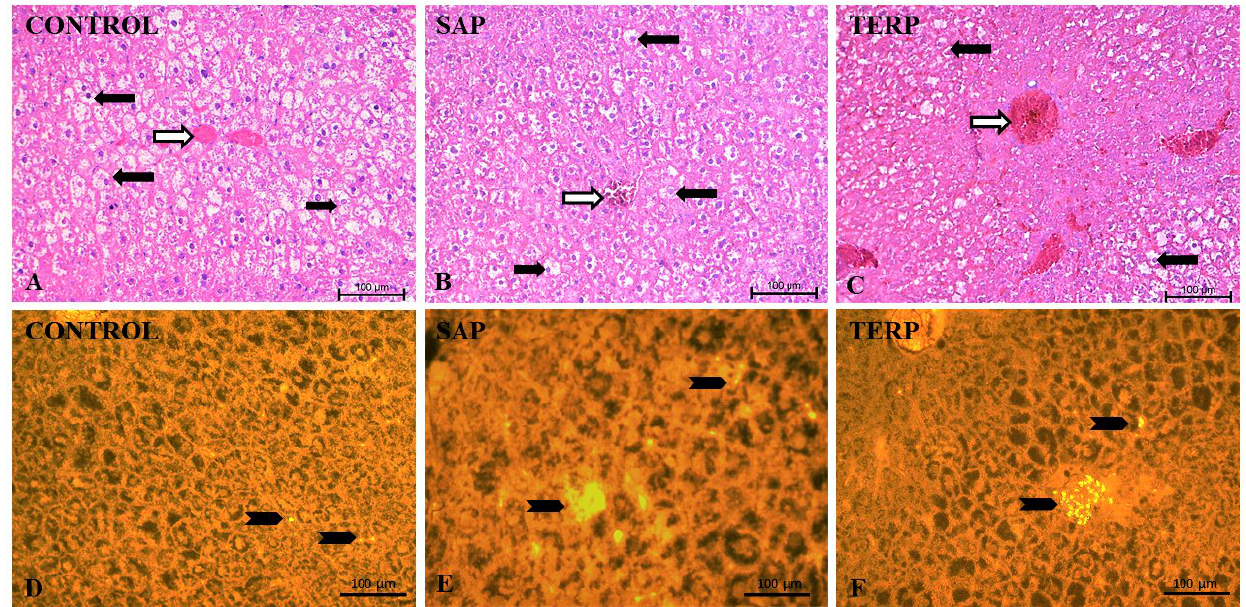
Figure 4. Representative pictures of rat liver stained with hematoxylin and eosin (( A – C ) upper panel) and PMP70 immunohistochemical staining for the 70 kDa peroxisomal membrane protein marker PMP70 (( D – F ) yellow signals in lower panel; solid arrowhead = positive signals detecting the presence of the peroxisomes in controls and experimental groups). Note the degree of steatosis— different amounts and sizes of the fat droplets in the hepatocytes (solid arrows = hepatocytes; open arrows = central vein) in pictures stained with hematoxylin and eosin. Mag. 200×. Scale bar 100 µm ( A – F ).